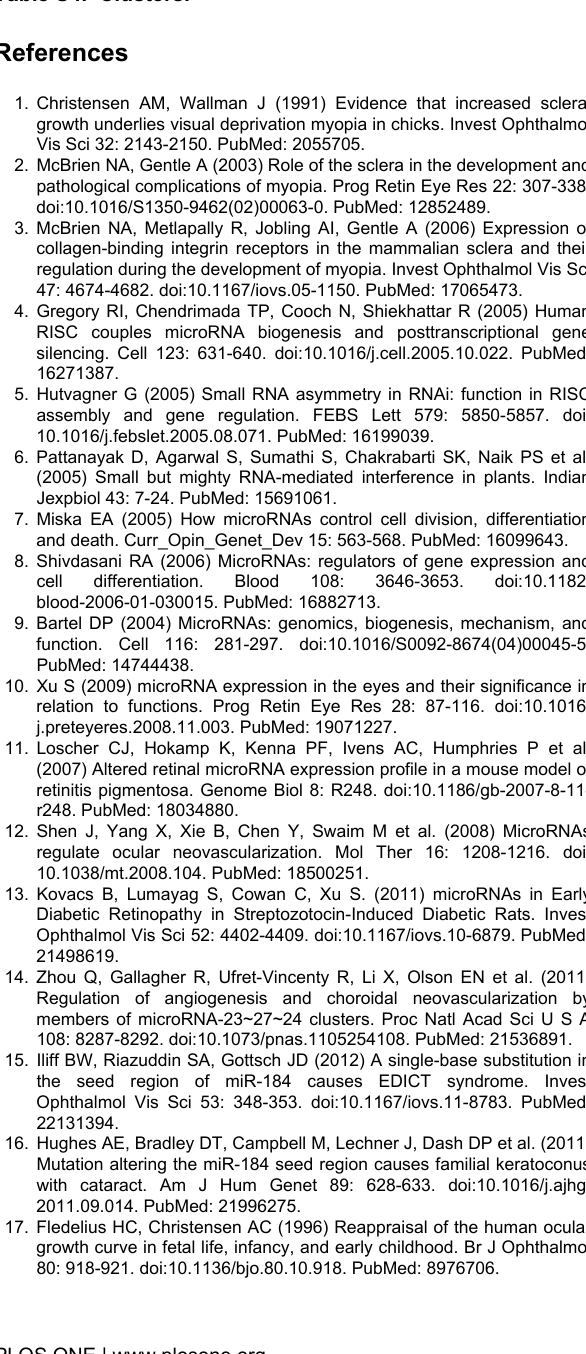
Table S3. Gene expression differences.